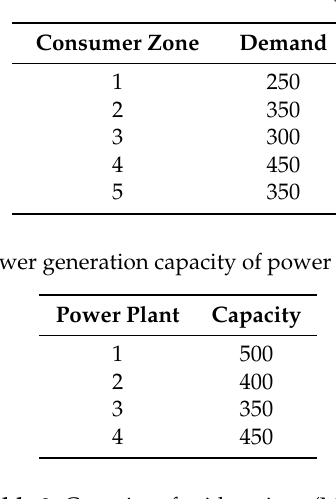
Table 3. Capacity of grid stations (MW).